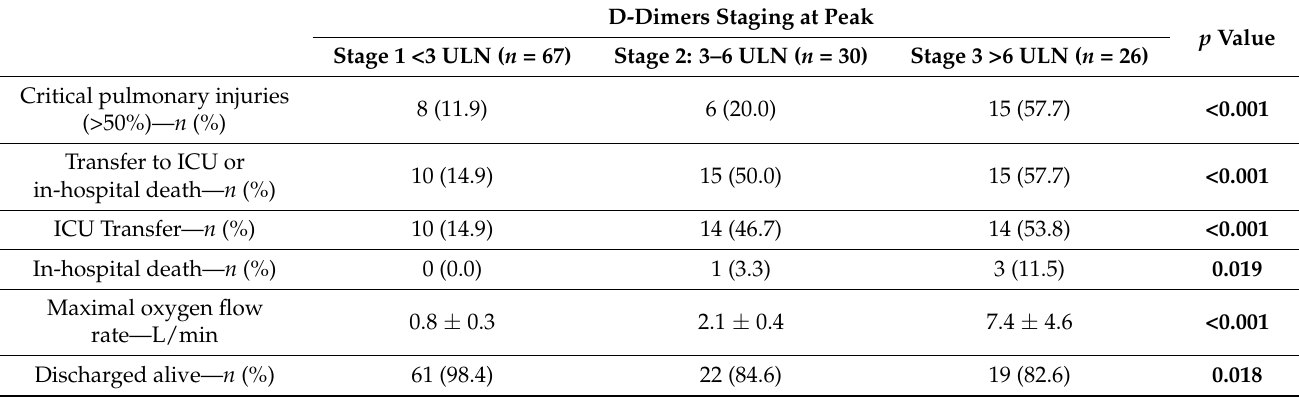
Figure 2. Extent of lung injuries assessed by chest computed tomography according to D-Dimers staging at peak. There was a stepwise increase in lung injuries according to D-Dimers staging at peak, with critical lung injuries defined by an extent >50% on chest computed tomography evidenced in 8 (11.9%) patients in Stage 1, 6 (20.0%) in Stage 2 and 15 (57.7%) in Stage 3 ( p = 0.001). Abbreviations: ULN, upper limit of normal. Table 3. Outcomes of the study population according to D-Dimers staging at